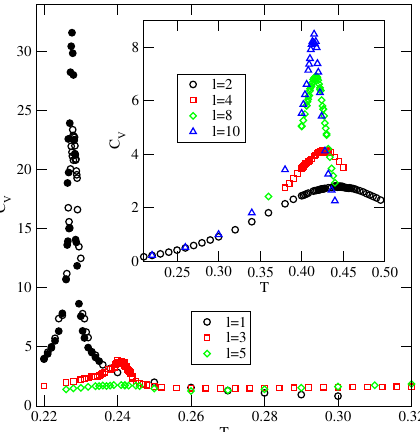
Figure 22. The heat capacity curves for the system with u BB = 0 and u AB = 0.0. The main part (inset) shows the results for odd (even) numbers of occupied layers. The open and filled symbols mark the results of the calculations for the simulation cells with L = 40 and 60,